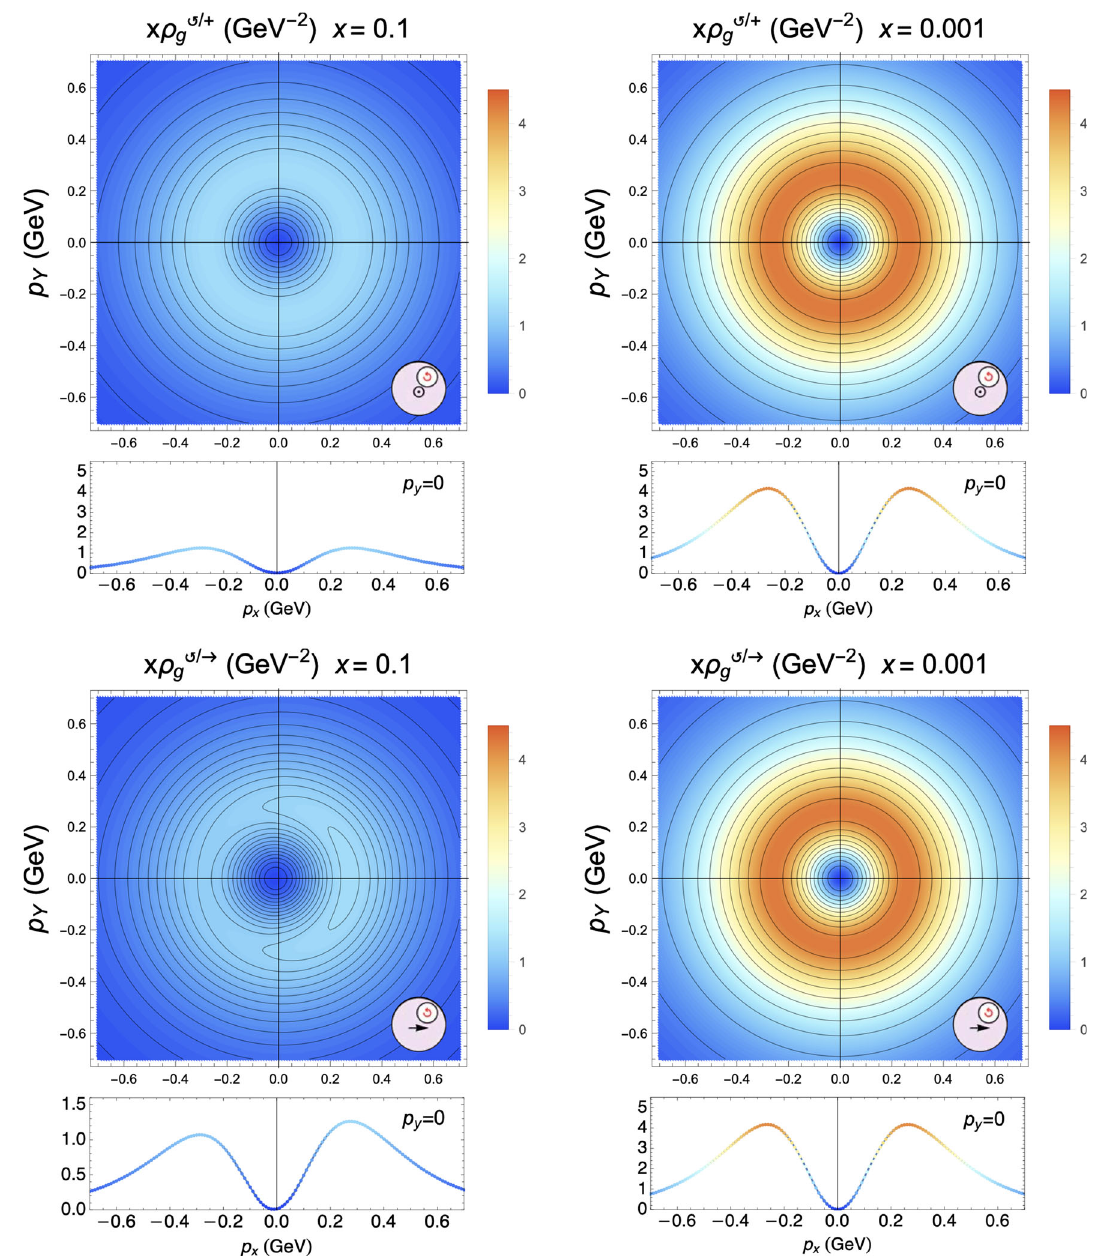
Fig. 6 From top to bottom, the gluon densities of Eqs. (21) and (22) as functions of p T at Q 0 = 1 . 64 GeV and at x = 0 . 1 (left panels) and x = 0 . 001 (right panels) for a polarized nucleon virtually moving